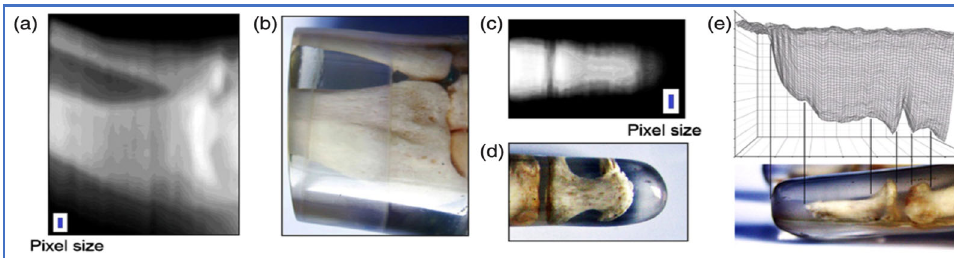
Figure 4. The 8-bit X-ray grey-scale contour maps recorded using GaN-HEMTs (the total device size is indicated (white) and the active area (blue)) of a human ( a ) wrist and ( c ) index finger phantom. Optical pictures of the scanned ( b ) wrist and ( d ) finger phantom. ( e ) Side view of a 3D plot of the data in ( c ) compared to an optical image in the same orientation ([42]; copyright IOP Publishing, 2011).